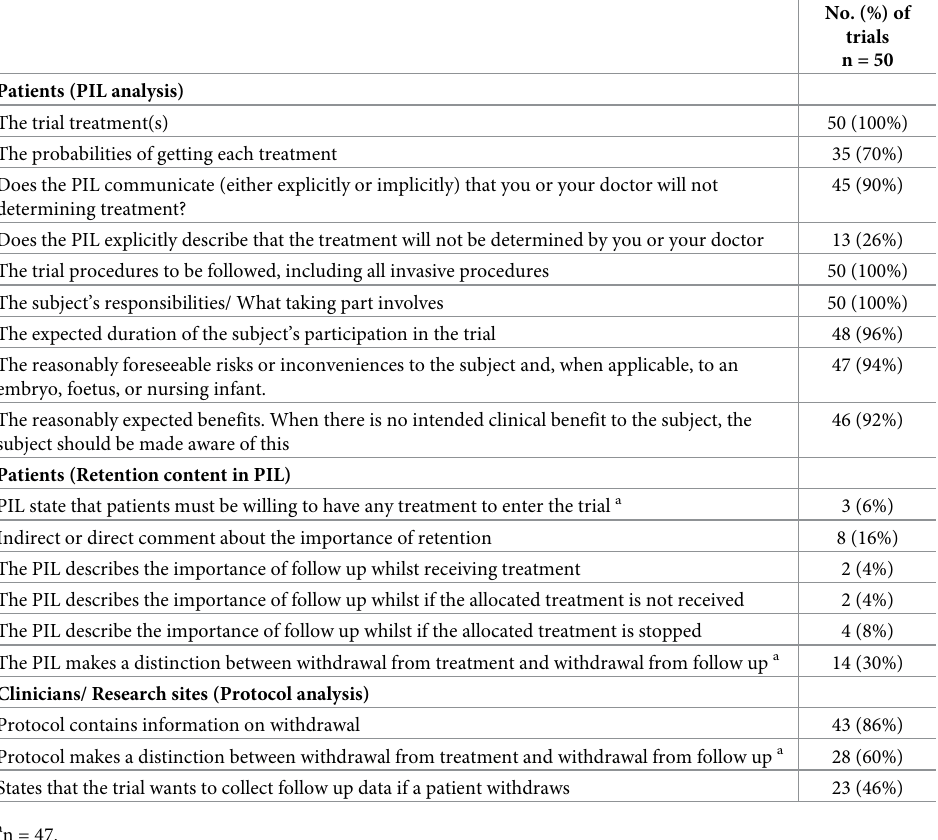
Table 3. Frequency of trial information communicated within PIL and